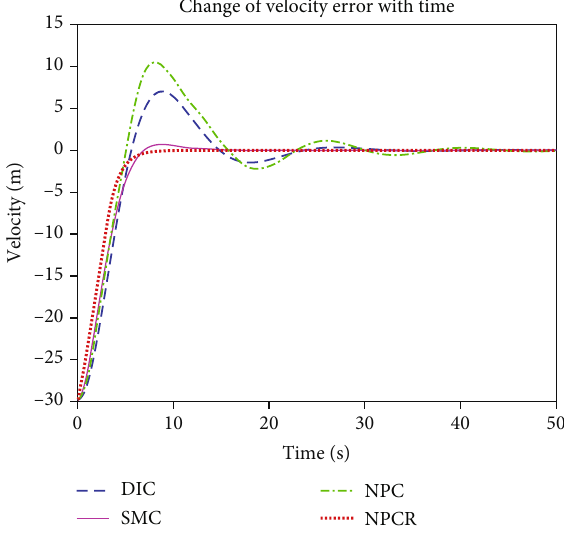
Figure 5: Velocity error changes with time under di ff erent controllers.